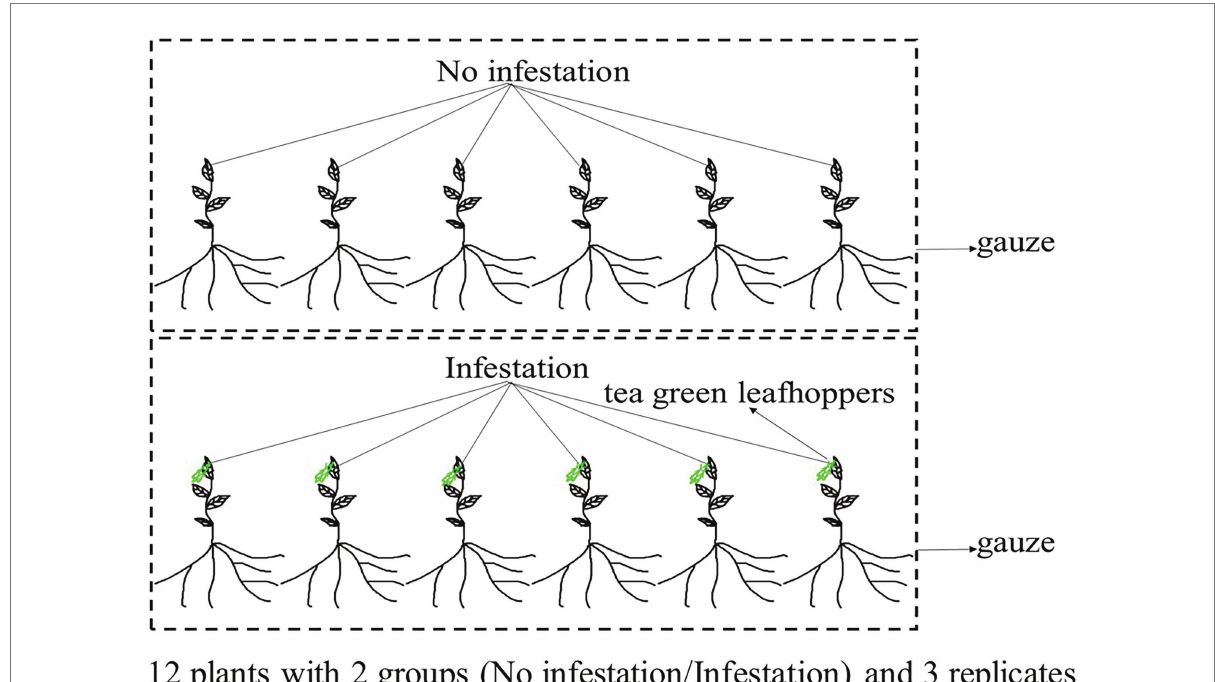
FIGURE 1 Experimental design. One group of the tea plants were not infested by tea green leafhoppers, and the other were infested by tea green